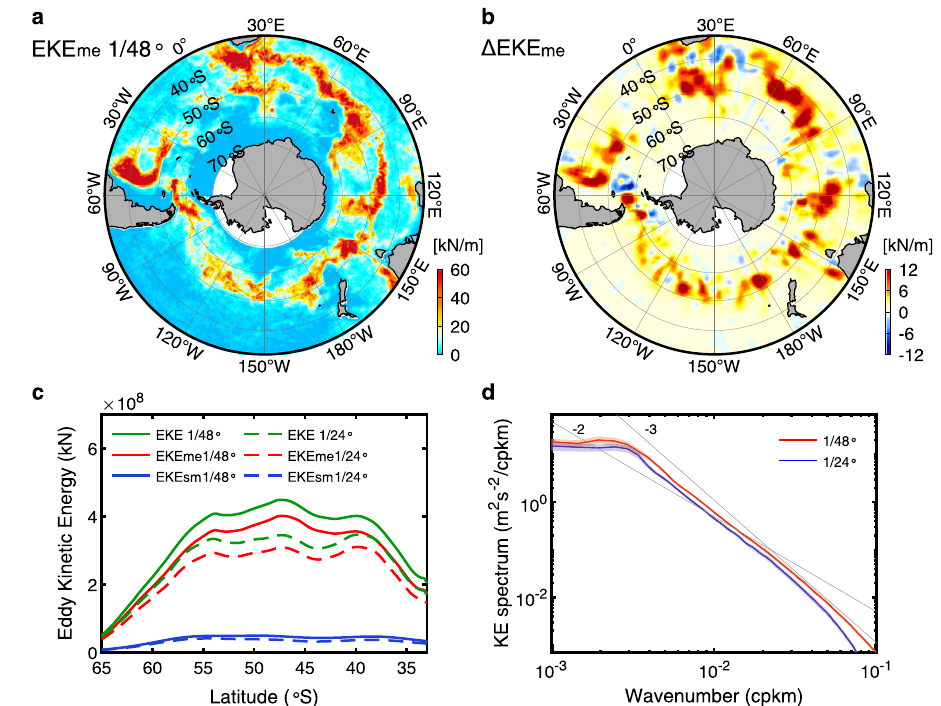
Fig. 3 | Comparisons of different eddy kinetic energy in the Southern Ocean. a Vertically integrated mesoscale eddy kinetic energy (EKE) in the upper 1000m averaged over the simulation period from the 1/48° simulation outputs. b Same as a but for the difference between the 1/48° and 1/24° simulation-derived mesoscale EKE (the former minus the latter). c Latitudinal distributions of zonally integrated EKEs.Green,red,andbluelinesdenotethetotal,mesoscale,andsubmesoscaleEKE, respectively. Results from the 1/48° and 1/24° simulations are denoted using solid and dashed lines, respectively. d Annually averaged kinetic energy spectra